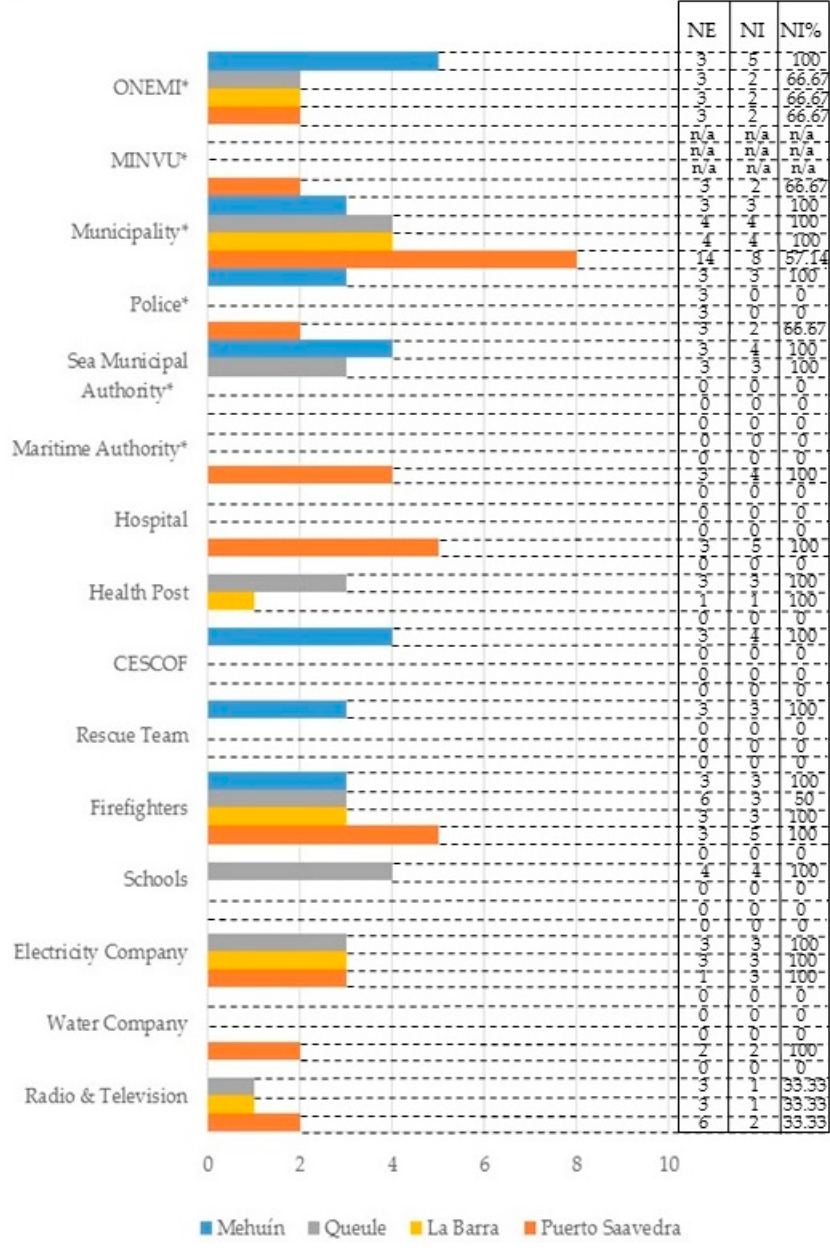
Figure 2. Percentage of people interviewed from each emergency institution. Note: ONEMI stands for the National Emergency Office. MINVU stands for the Ministry of Housing and Urbanism. CESCOF stands for Family Health Center. NE stands for Expected number of interviews. NI stands for number of interviews undertaken. NI% stands for the percentage of number of interviews undertaken. The * indicates governmental institutions. Table 1. Roles of emergency institutions.